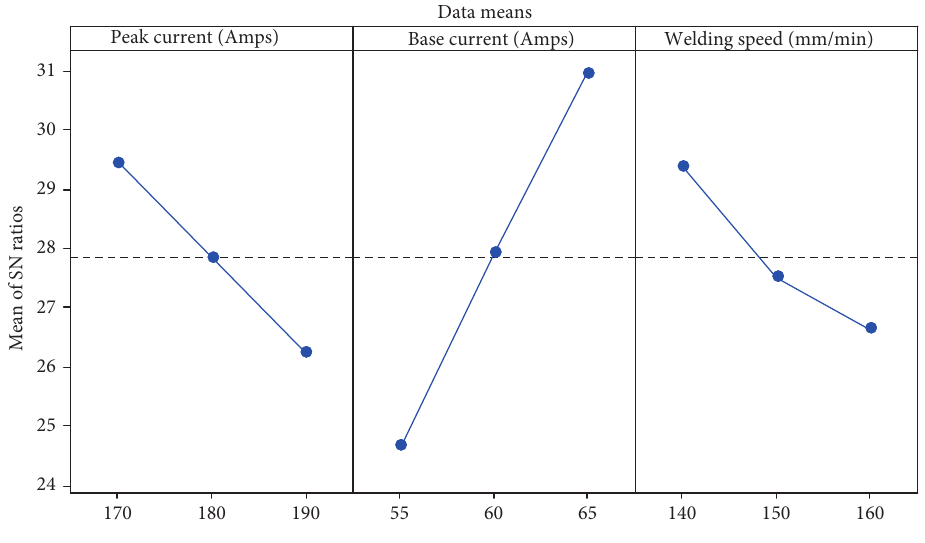
Figure 10: Main effect plot for S/N